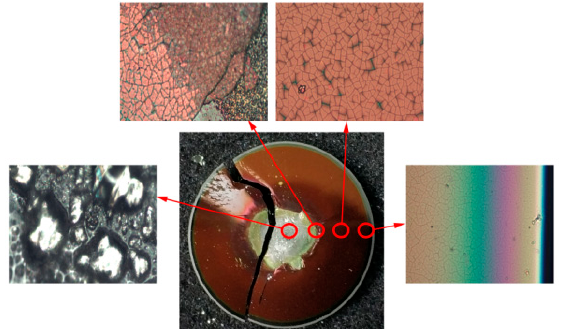
Appl. Sci. 2020 , 10 , x FOR PEER REVIEW Figure 3. Damage of silicon broadband window (200 × ). Figure 3. Damage of silicon broadband window (200×) . Figure 3. Damage of silicon broadband window (200×) .